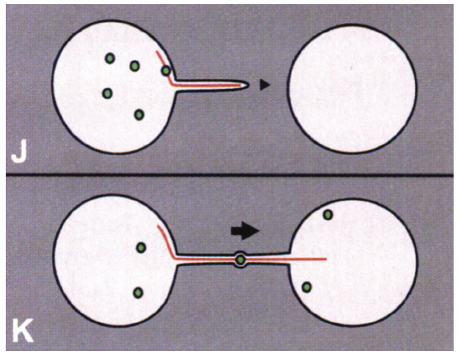
Figure 1 Biomembrane nanotube connecting two neural cells (cited from [5]).